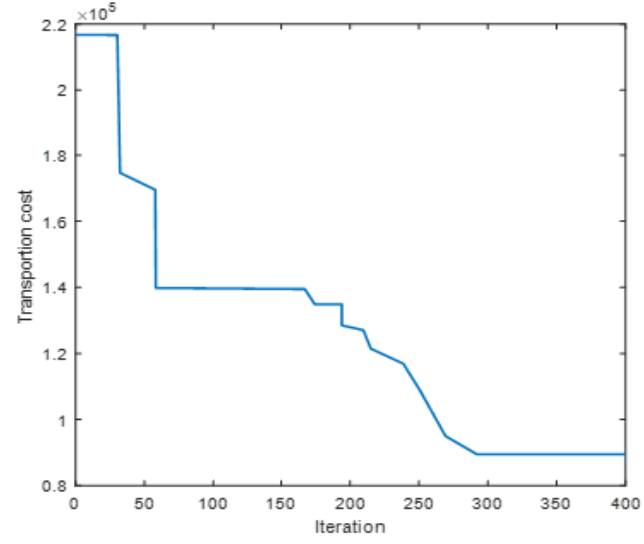
Figure 16. Cost target iteration curve of EGA algorithm.